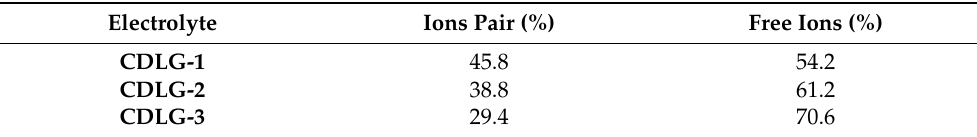
Table 3. The percentages of ion species using FTIR method.